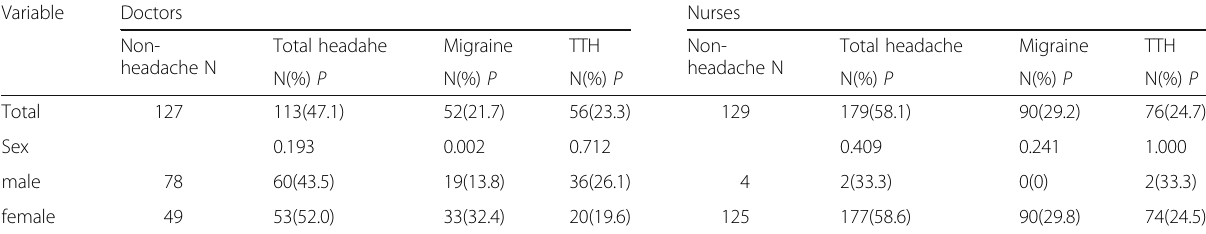
Table 2 Prevalence of migraine and Tension-type headache among doctors and nurses of different genders Variable